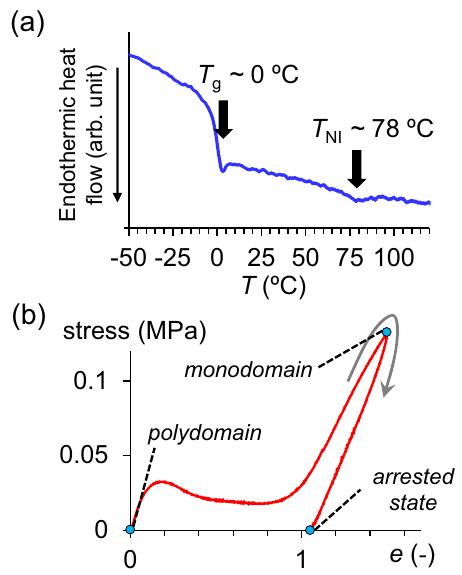
Fig. 2 Thermal and mechanical properties of LCE after the fi rst crosslinking. a DSC heating curve of the LCE acquired at 5°C/min prior to the second crosslinking. b Stress – strain (SS) curve of the LCE in a strain cycle of 0 → 1.5 → 0 in the x -direction measured at a strain rate of 0.0033s − 1 prior to the second crosslinking. A residual strain of e r ∼ 1.05 emerged as the arrested state after strain